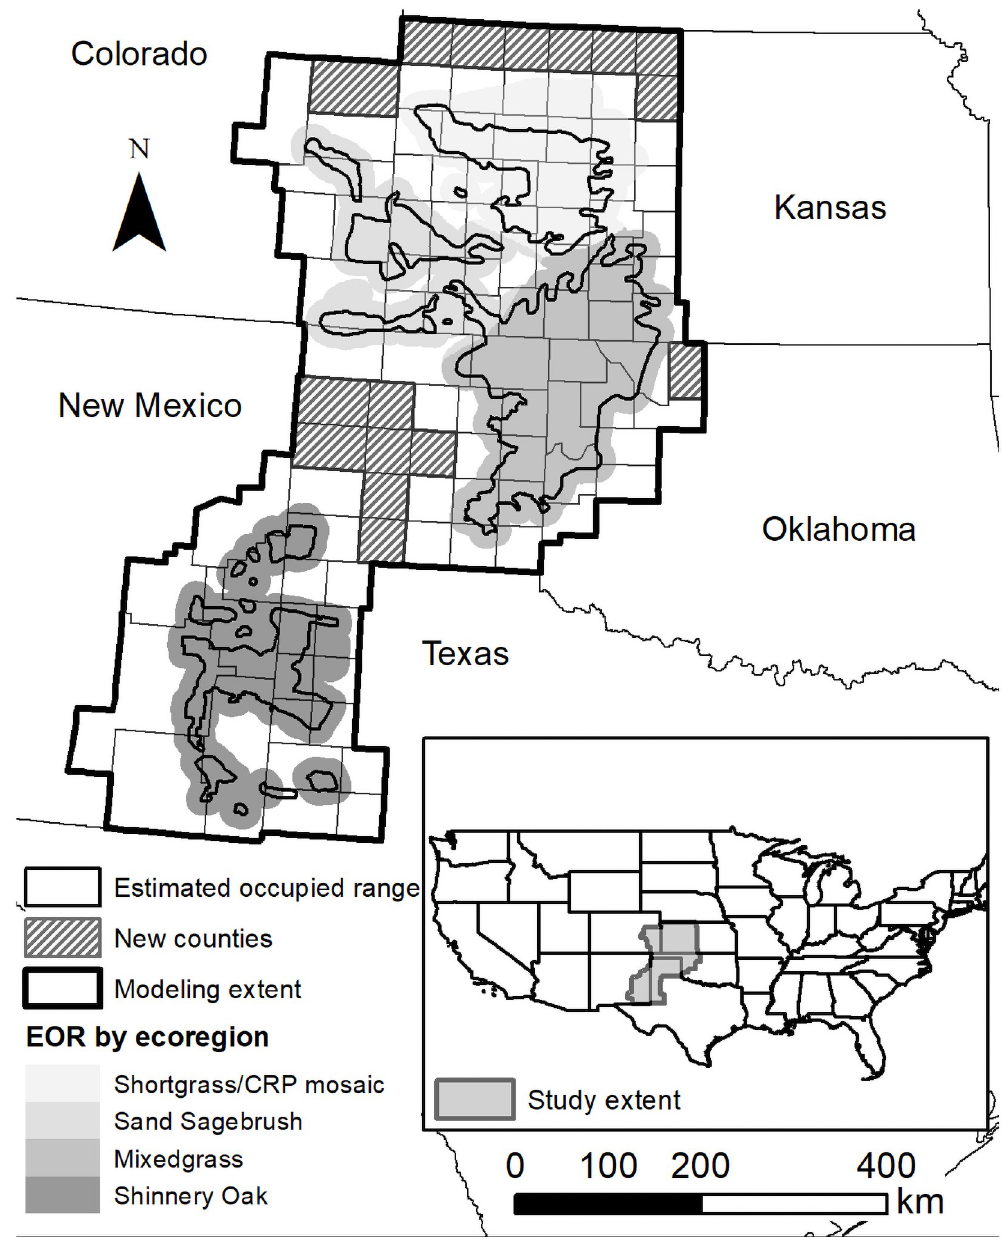
Fig 1. Study site location map. The extent of the second iteration habitat suitability model for lesser prairie-chicken leks across the five states of its current range, overlaid with the species’ Estimated Occupied Range (EOR) area, buffered by 16.1 km, and shaded by ecoregion. Second iteration study extent added the new counties to the initial iteration extent. [Projected Coordinate System: Albers Conic Equal Area].